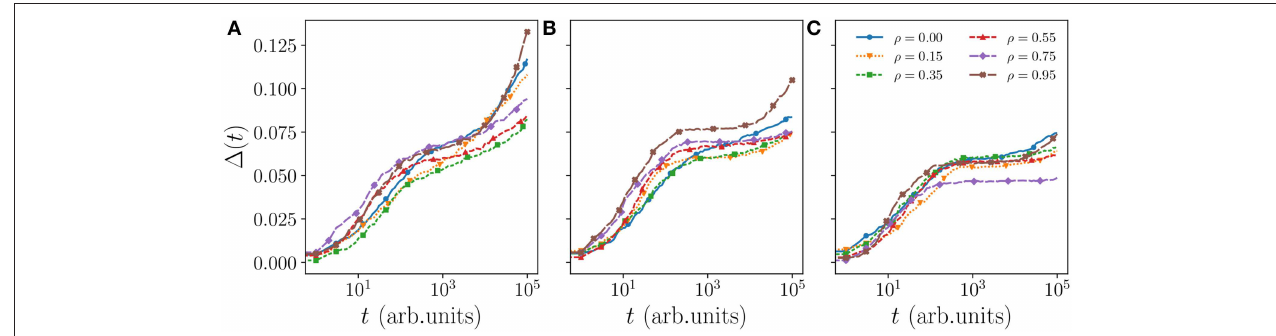
FIGURE 1 | MSD 1 ( t ) of a walker in a system with ν 48 and L 120, where each curve is a snapshot average. The active scent times ( T A ) for panels (A–C) are = = t α relationship where α > 1. For intermediate 712, 1,068, and 1,424, respectively. At short timescale the walkers tend to exhibit superdiffusion indicated by the 1 ( t ) ∝ timescales the dynamics of the walkers are governed by the mobility of their territories. High values of T A yield slowly moving territories and increase in caging caused by neighbors. This caging saturation is highly sensitive to the correlation of the walkers (see Figure A2 ) while the time spent at the caging saturation before increasing again is related to the coverage efficiency of the